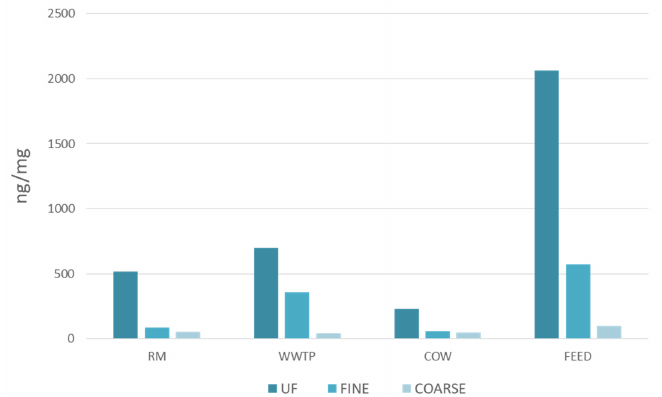
Figure 5. Distribution of the toxics analyzed in the three fractions of PM in each sampling site.